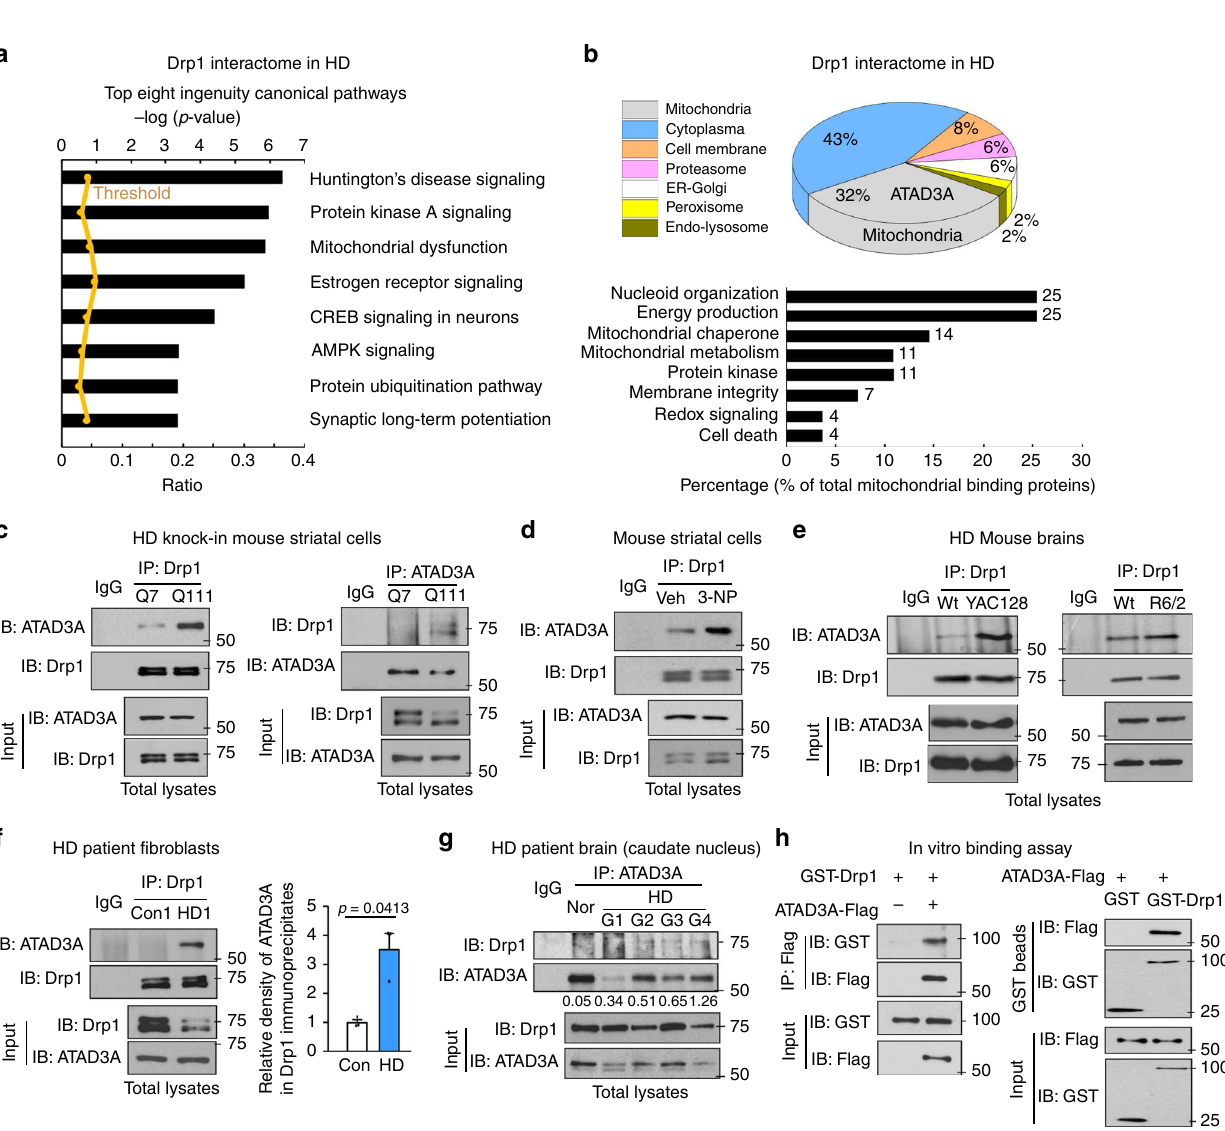
Fig. 1 ATAD3A binds to Drp1 in HD. a Af fi nity puri fi cation followed by tandem mass spectrometry analysis was conducted to identify Drp1-interacting proteins in striatal neuronal cells derived from HD patient-iPS or normal subject-iPS cells (also see Supplementary Fig. 1A). The molecular and cellular functions of the Drp1 interactors in HD patient-derived neuronal cells are shown. b Upper: cellular location of the Drp1 interactors in HD neuronal cells. In particular, 32% of proteins are located on the mitochondria. ATAD3A ranked as a top candidate. Lower: Among mitochondrial candidates, mitochondrial nucleoid organization and energy production are enriched, and each account for up to 25% of all mitochondrial candidates. Immunoprecipitation (IP) of total protein lysates was performed in HdhQ7 and HdhQ111 cells ( c ), in wildtype striatal cells exposed to 3-NP (5 mM for 4 h) ( d ), in striatal extracts of YAC128 mice (6 months old) or R6/2 mice (12 weeks old) or age-matched wildtype mice ( e ), and in fi broblasts of HD patient (HD1, GM4208, 35 years old, Male) or normal subject (Con1, Huf1) ( f ). Data are mean ± SEM. Student t test. n = 3. g Total protein lysates of frozen postmortem caudate nucleus of normal subjects and HD patients with different disease severity (grade 1 to grade 4, slight to severe) were subject to IP analysis. Nor: normal subject 5214; G1: HD 4283, grade 1; G2: HD 4557, grade 2; G3: HD 3573, grade 3; G4: HD 2903, grade 4. Patient information shown in Supplementary Fig. 1F. The data below the blots indicate the relative density of Drp1 in ATAD3A immunoprecipitates (Drp1/ATAD3A in IP analysis). h GST-Drp1 (2 µ g) and ATAD3A-Flag (2 µ g) puri fi ed proteins were incubated in vitro for 30 mins. Left: IP with anti-Flag antibodies followed by western blot with the indicated antibodies. Right: GST pull down analysis. All shown representative blots are from at least 3 independent side of the OMM (Fig. 2c). These data indicate an enhanced the treatment of cells with BMH (in vivo cross-linking) led to localization of ATAD3A at contact sites in HD cells. increased oligomerization of ATAD3A, the extent of which was Structural prediction identi fi ed two CC domains within the N consistently greater in HdhQ111 cells than in HdhQ7 cells (Fig. 2d). terminus of ATAD3A that may participate in higher-order ATAD3A The increased oligomers of ATAD3A was again observed in oligomerization (Supplementary Fig. 2A). Under non-reducing mitochondrial fractions of HdhQ111 cells after cross-linking with conditions, ATAD3A dimerization increased both in HdhQ111 cells DTSSP (3,3 ’ -dithiobis(sulfosuccinimidyl propionate)) (Supplemen- (Fig. 2d) and in Neuro2a cells exposed to 3-NP (Supplementary tary Fig. 2C) and in total lysates of HEK293 cells after crosslinking Fig. 2B). Both the addition of the chemical crosslinker BMH with DSP (dithiobis(succinimidyl propionate)) (Supplementary (bismaleimidohexane) to total cell lysates (in vitro cross-linking) and Fig. 2D). Notably, ATAD3A oligomers increased in HD YAC128